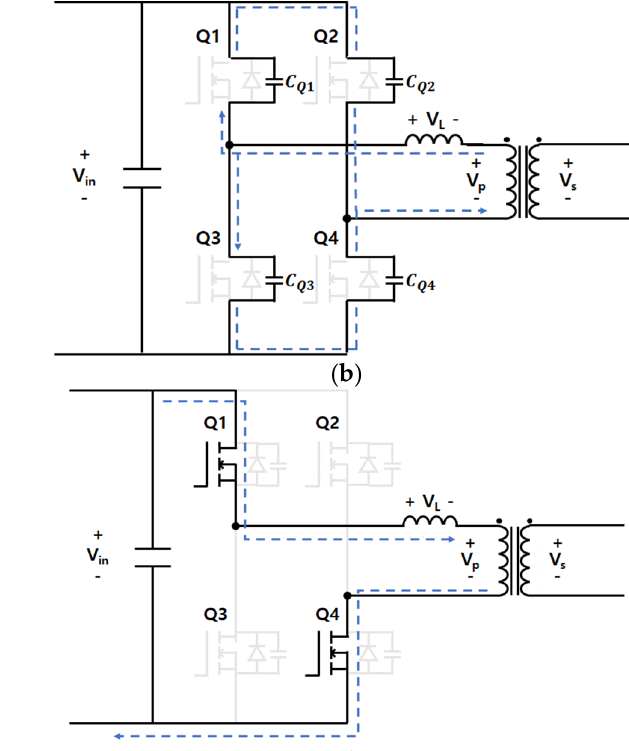
Figure 3. Parasitic components of MOSFET.